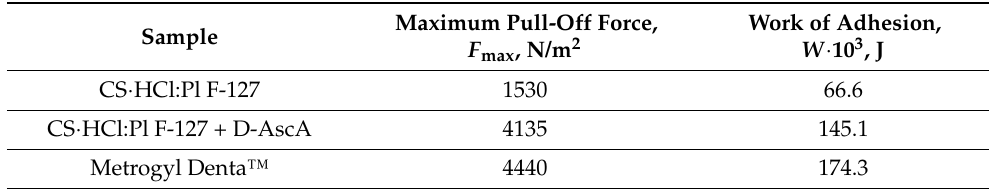
Table 1. Adhesive characteristics of the CS · HCl:Pl F-127 = 30:70 hydrogels with C CS · HCl = 3 wt.%, C Pl F-127 = 25 wt.% without and with the addition of 3 wt.%